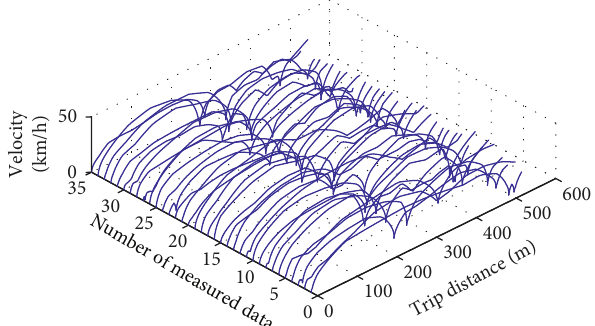
Figure 4: The dataset of a kinematic